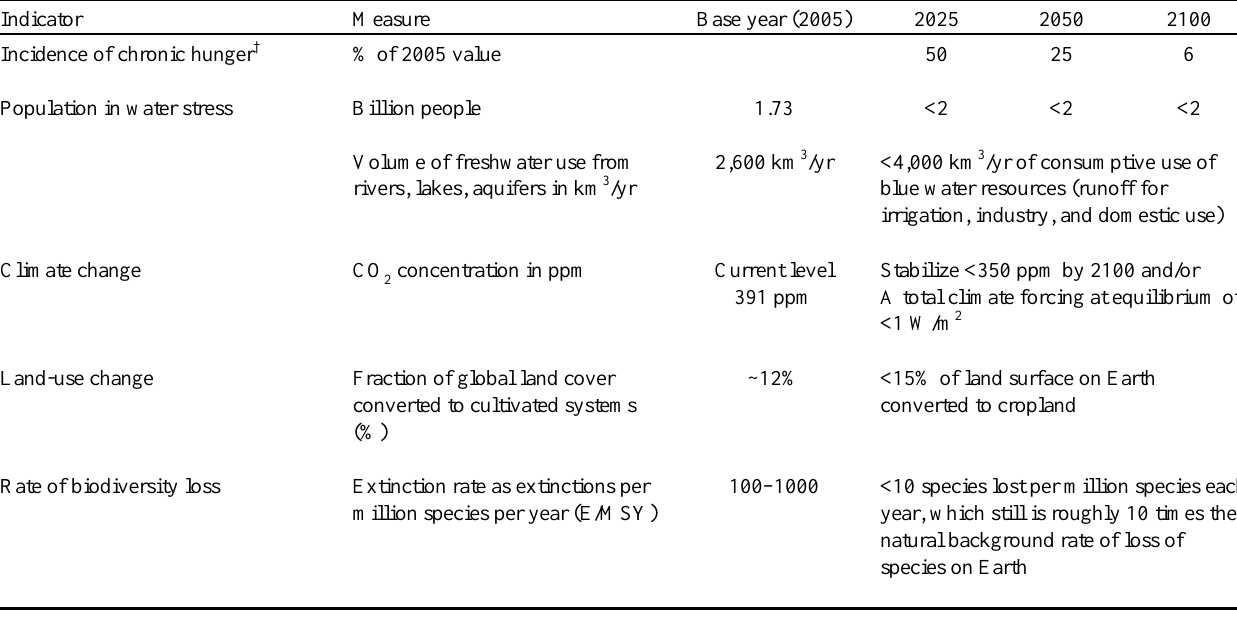
Table 1. Selected provisional sustainable development goals (from among those defined by planetary boundaries and Polestar transition scenarios, Raskin et al.